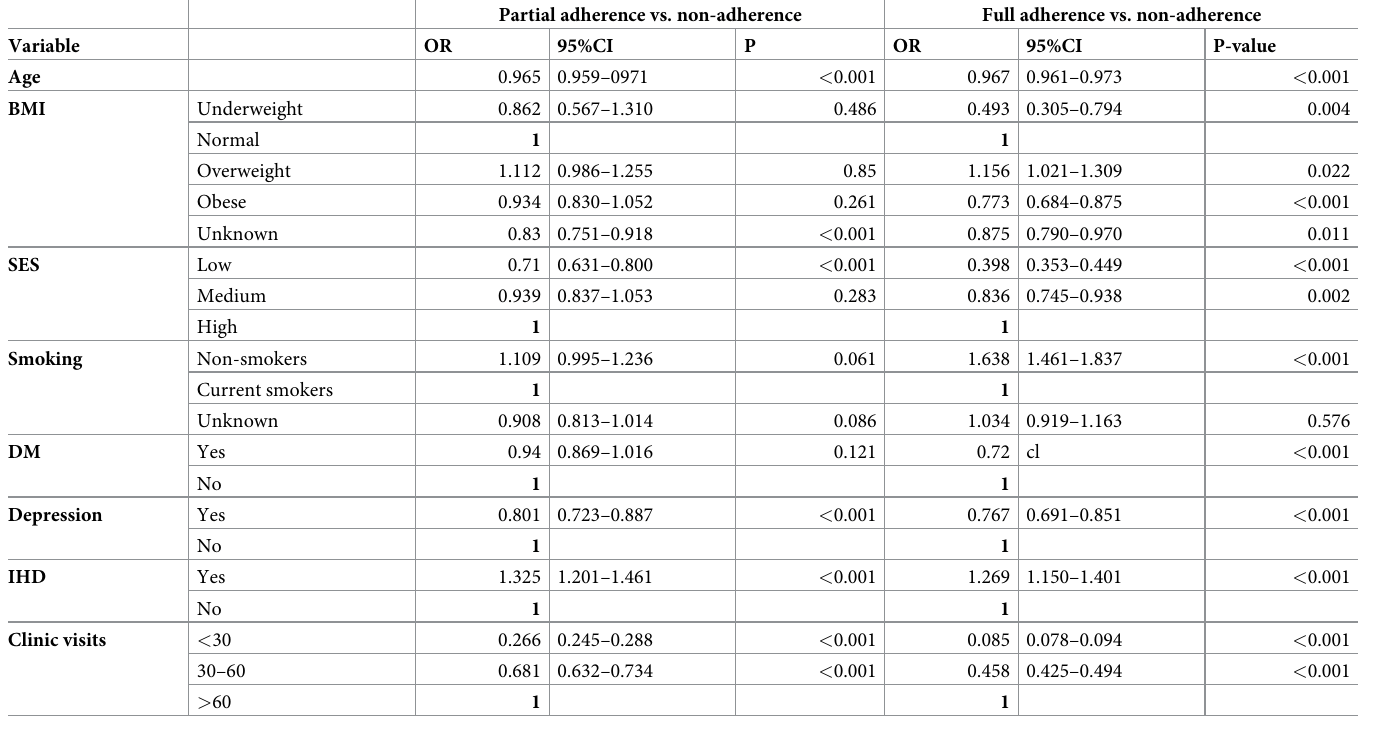
The results of a multinomial logistic regression analysis are shown, with non-adherence as the reference category. Since, adherence decreased with age; the remaining variablesare age-adjusted. The reference category for the dependent variables was set as non-adherence. The reference category within each independent variable was set to an odds ratio of one.